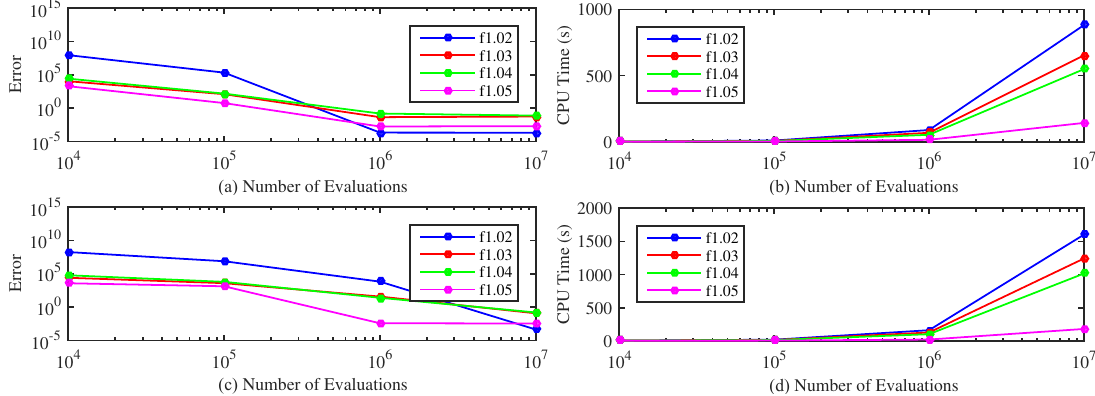
Figure 6. Study of the error to attain the global optimum ( a ) and CPU time ( b ) for functions of dimension 100 ( c ) and dimension 200 ( d ) using the GDS